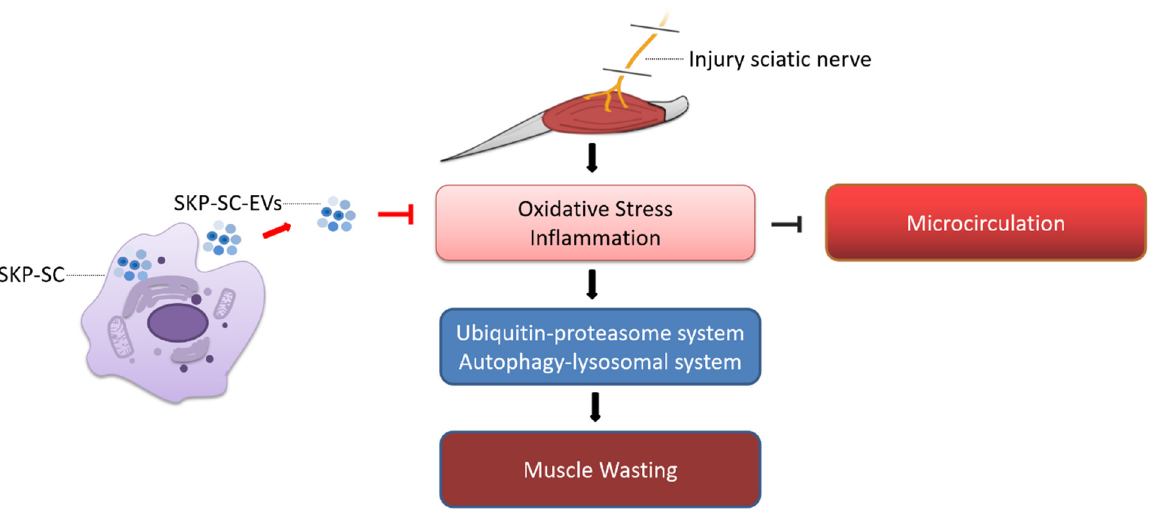
Figure 12. Schematic diagram illustrating how SKP-SC-EVs may alleviate denervation-induced de- crease in the blood flow of target muscles by inhibiting oxidative stress and inflammation, improving microcirculation, and inactivating the ubiquitinated proteolytic and autophagy-lysosomal pathways, thereby alleviating denervated skeletal muscle atrophy.